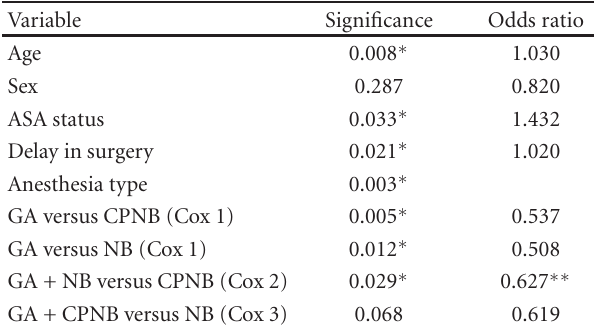
Figure 1: The graph shows a Kaplan-Meier survival curve for gen- eral anesthesia (GA), neuraxial block (NB), and combined periph- eral nerve block (CPNB) patients. Table 3: Summary of Cox regression